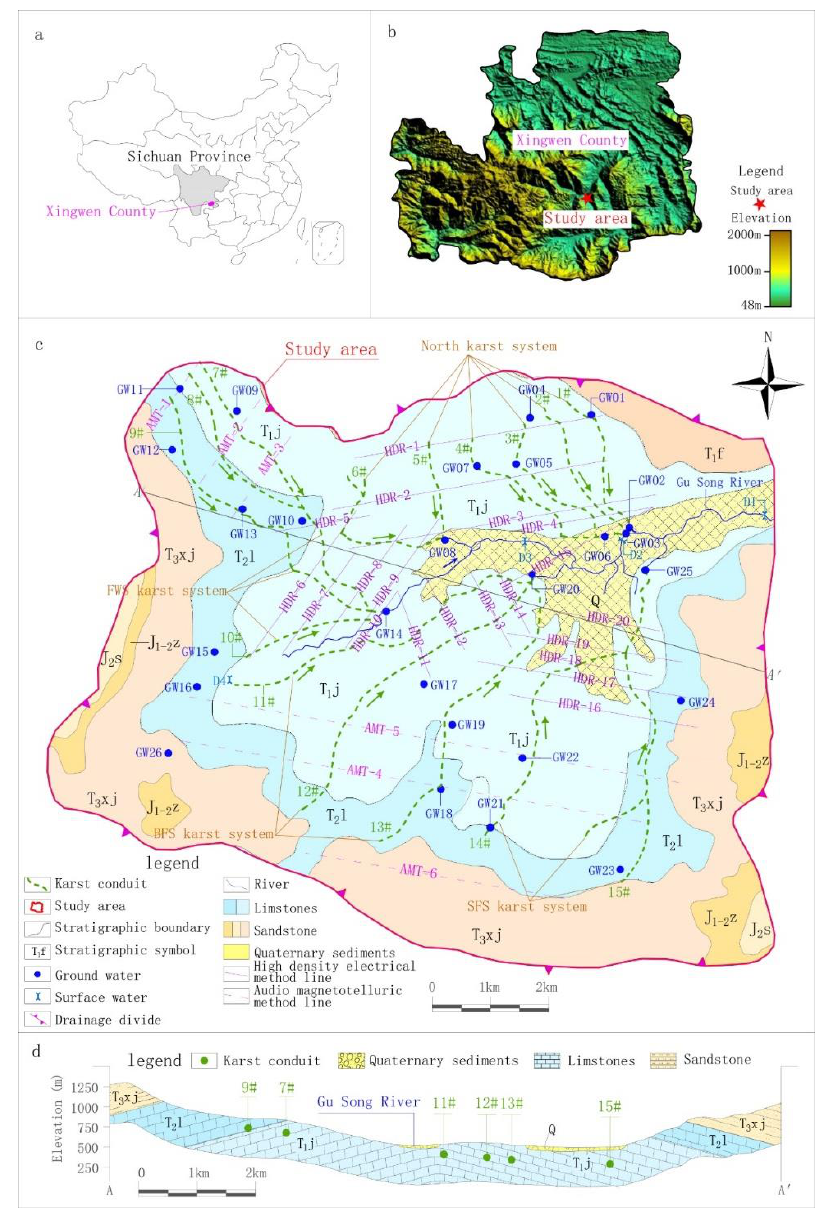
Figure 1. Location, sampling sites and hydrogeological map of the study area. ( a ) Location of the study area, ( b ) Topographic map of the study area. ( c ) Sampling sites and hydrogeological map of the study area, ( d ) Hydrogeological profile map of the study area.